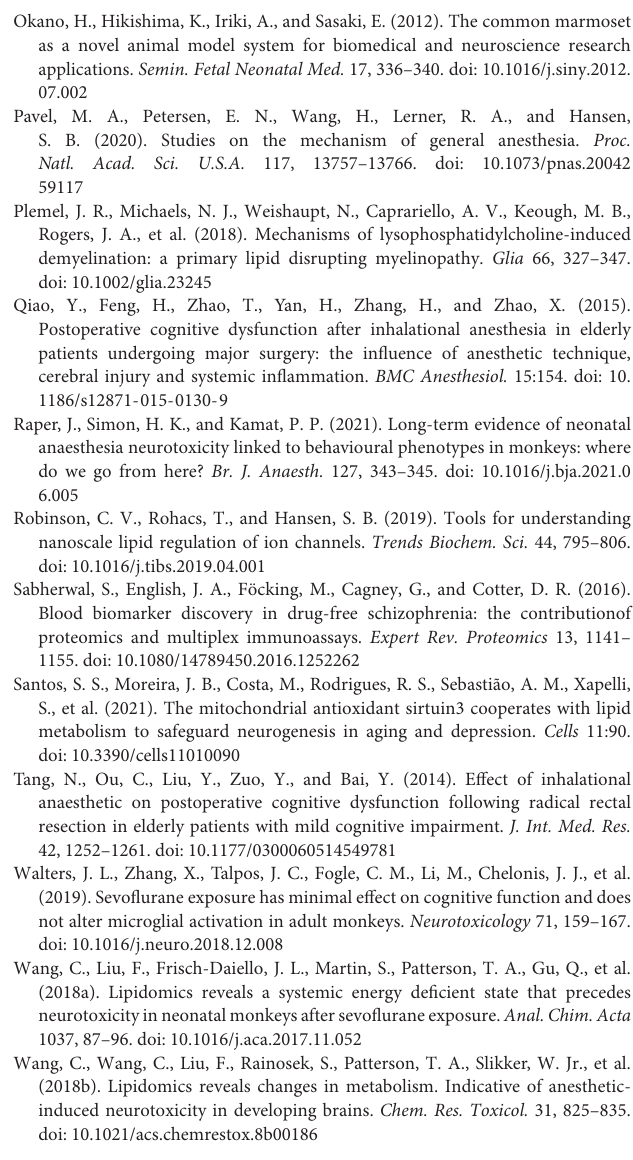
Supplementary Figure 1 | WGCNA analysis of marmosets and mice. (A) A total of 632 lipid components of marmosets were aggregated into 12 modules. Module 11: P < 0.05. (B) A total of 632 lipid components of mice were aggregated into 11 modules. Statistical analysis of the modules showed that P >